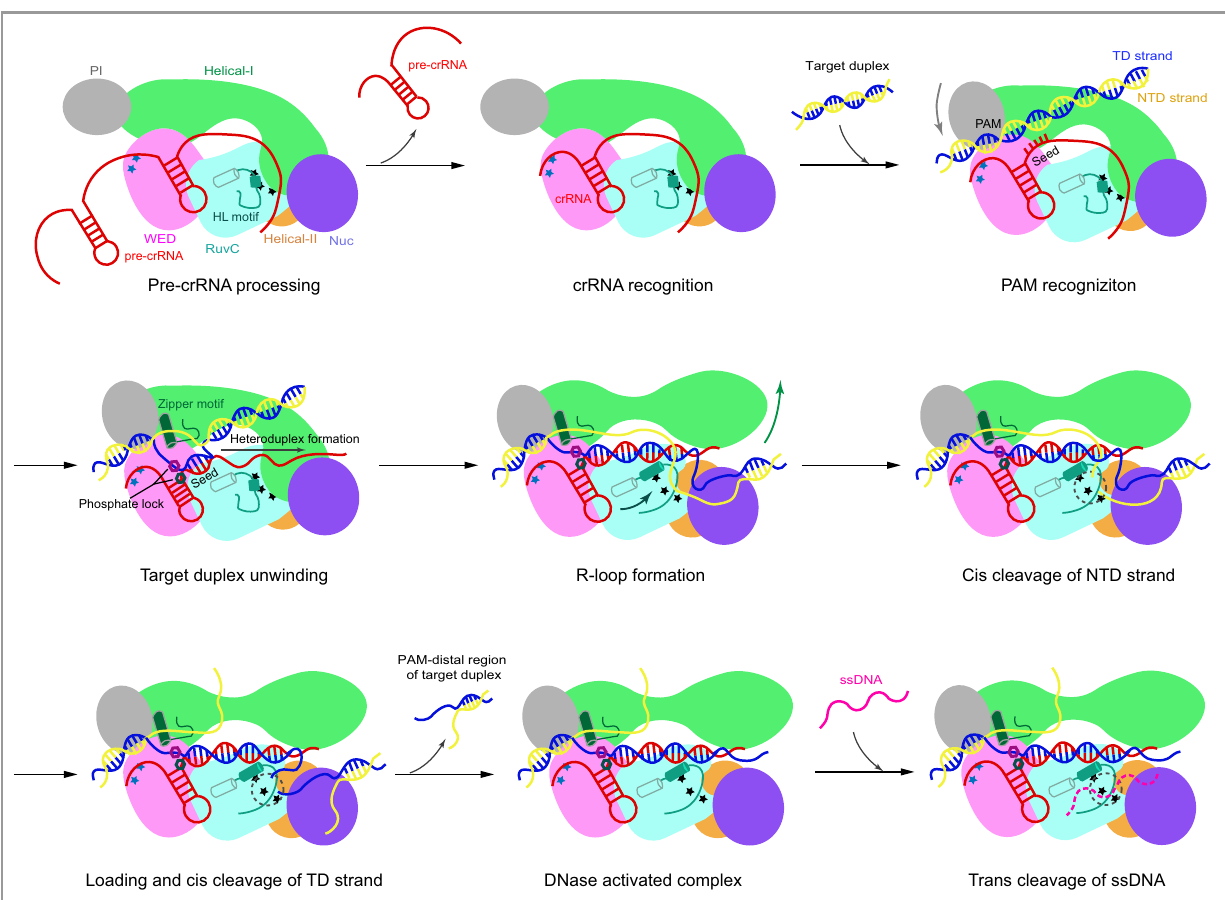
Fig. 7 A multi-step model for the activation of Cas12i1 cis - and trans -cleavage. The apo Cas12i1 recognizes pre-crRNA, processes it into mature crRNA, and forms a Cas12i1-crRNA binary complex. The open PAM-interacting cleft of the binary complex screens the DNA substrate. When matched with a correct PAM, the PAM-interacting cleft of Cas12i1 closes. The zipper motif and the phosphate lock work together to assist unwinding of the target duplex beyond the PAM, and the unwound TD strand is directed toward the preorganized crRNA seed region for interrogation. Correct matching with the crRNA seed region further advances the 19-bp heteroduplex formation, which concomitantly drives conformational rearrangements in Cas12i1. The Helical-I domain and the HL motif are released from the RuvC catalytic pocket to participate in forming of two parallel channels that accommodate the heteroduplex and the unpaired NTD strand, respectively. As a result, the R-loop is formed and the Cas12i1 DNase activity is conformationally activated. Meanwhile, the NTD strand is guided to the RuvC catalytic pocket and cleaved. The Helical-II and Nuc domains then promote unwinding of the PAM-distal target DNA duplex and loading of the TD strand into the RuvC catalytic pocket, following which the TD strand is cleaved and the PAM-distal cleavage product is released from the complex. The activated Cas12i1 could cleave any available single-stranded DNA (ssDNA) in trans unlabeled Cas12i1 (wild type) binary complex were obtained following the protocol described above.